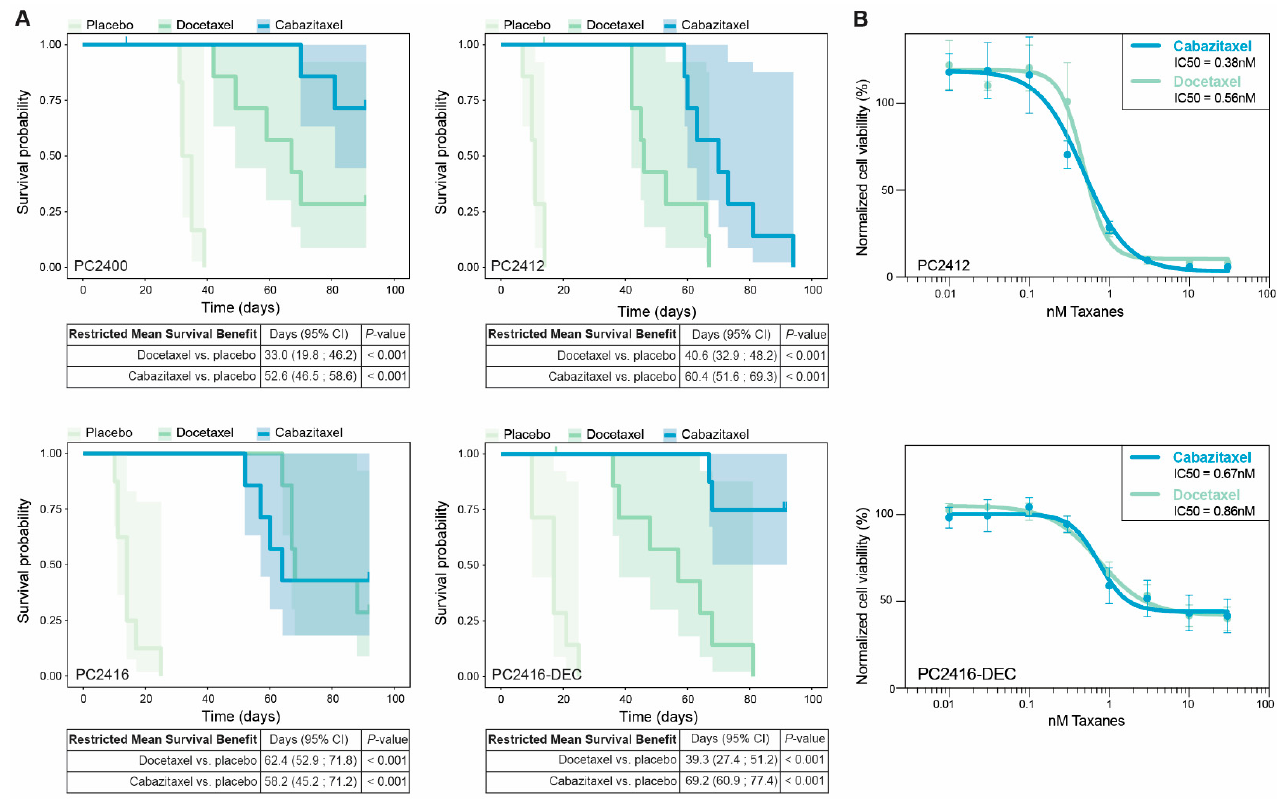
Figure 5. Responses of PDXs and PDXOs to taxane treatment. ( A ) Kaplan Meier plots depicting disease-specific survival of the tumor-bearing mice treated with placebo, docetaxel or cabazitaxel for PDXs PC2400 (placebo n = 6, docetaxel n = 7, cabazitaxel n = 8), PC2412 (placebo n = 7, docetaxel n = 8, cabazitaxel n = 7), PC2416 (placebo n = 8, docetaxel n = 7, cabazitaxel n = 7), and PC2416-DEC (placebo n = 7, docetaxel n = 8, cabazitaxel n = 8). Disease-specific survival was determined from the start of treatment (day 0) until tumor volumes exceeded 1500 mm 3 . Censored mice did not develop tumors of >1500 mm 3 during a maximum follow-up of 90 days or died from other causes. Tables display restricted mean survival benefit of docetaxel/cabazitaxel over placebo. ( B ) Dose-response curves of PC2412 PDXOs (upper panel) and PC2416-DEC PDXOs (lower panel) exposed to cabazitaxel (blue) or docetaxel (green). Dots indicate mean and error bars SEM of three and four individual experiments, respectively (six technical replicates per condition). Cell viability was normalized to vehicle (ethanol) controls. Half-maximal inhibitory concentration (IC50) was calculated by sigmoidal-curve fitting.